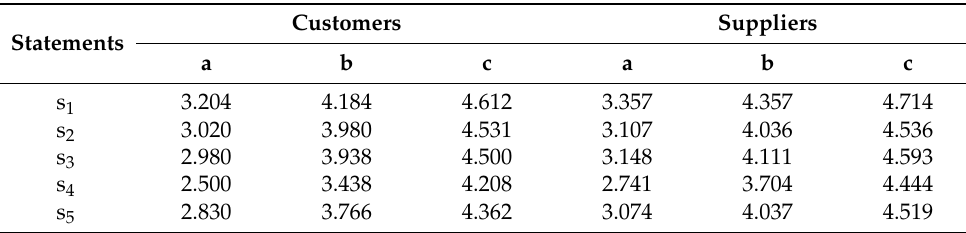
Table 2. Average ratings of the statements presented by the enterprise representatives in the form of triangular fuzzy numbers (a group of customers vs. a group of suppliers).